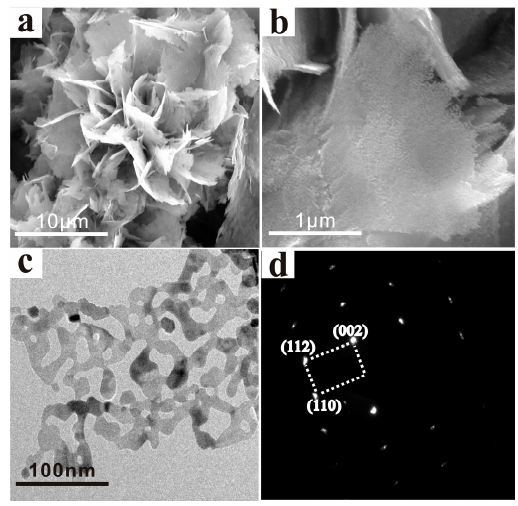
Figure 3. ( a , b ) SEM images, ( c ) TEM image and ( d ) corresponding SAED pattern of HPSCZNs.